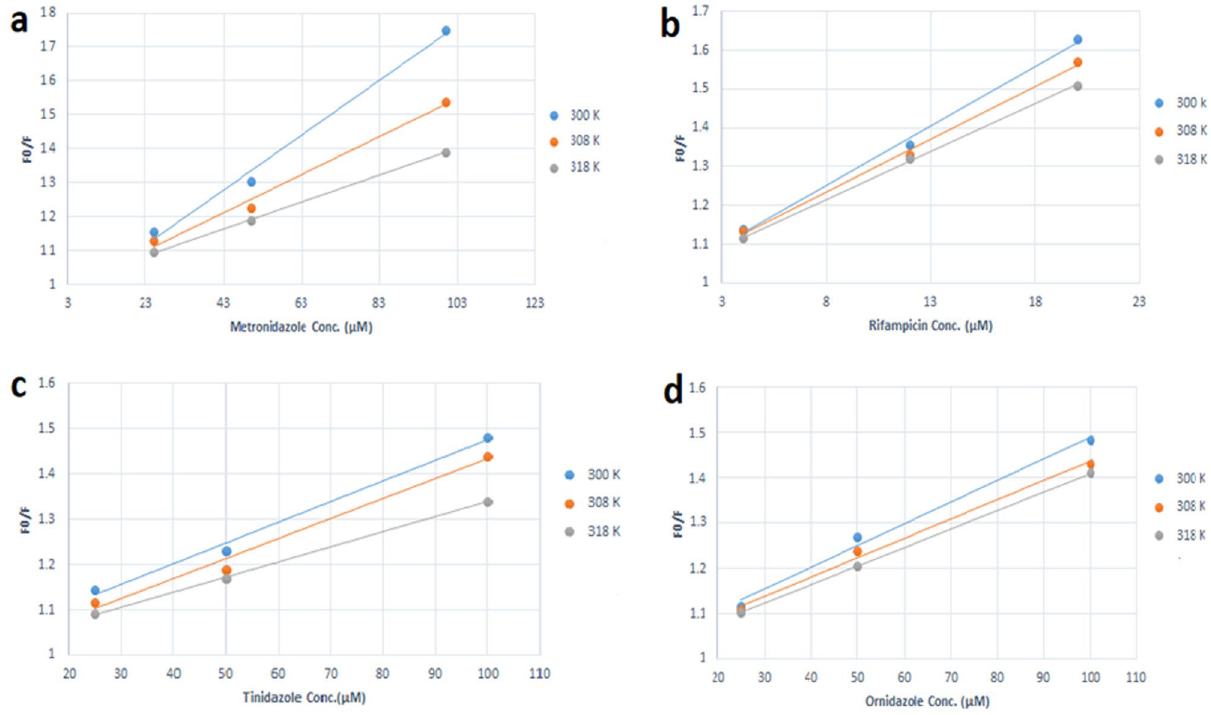
Figure 8. Stern–Volmer plots between F 0 /F and concentration (μM) of MNZ ( a ), RFP ( b ), TNZ ( c ), and ONZ ( d